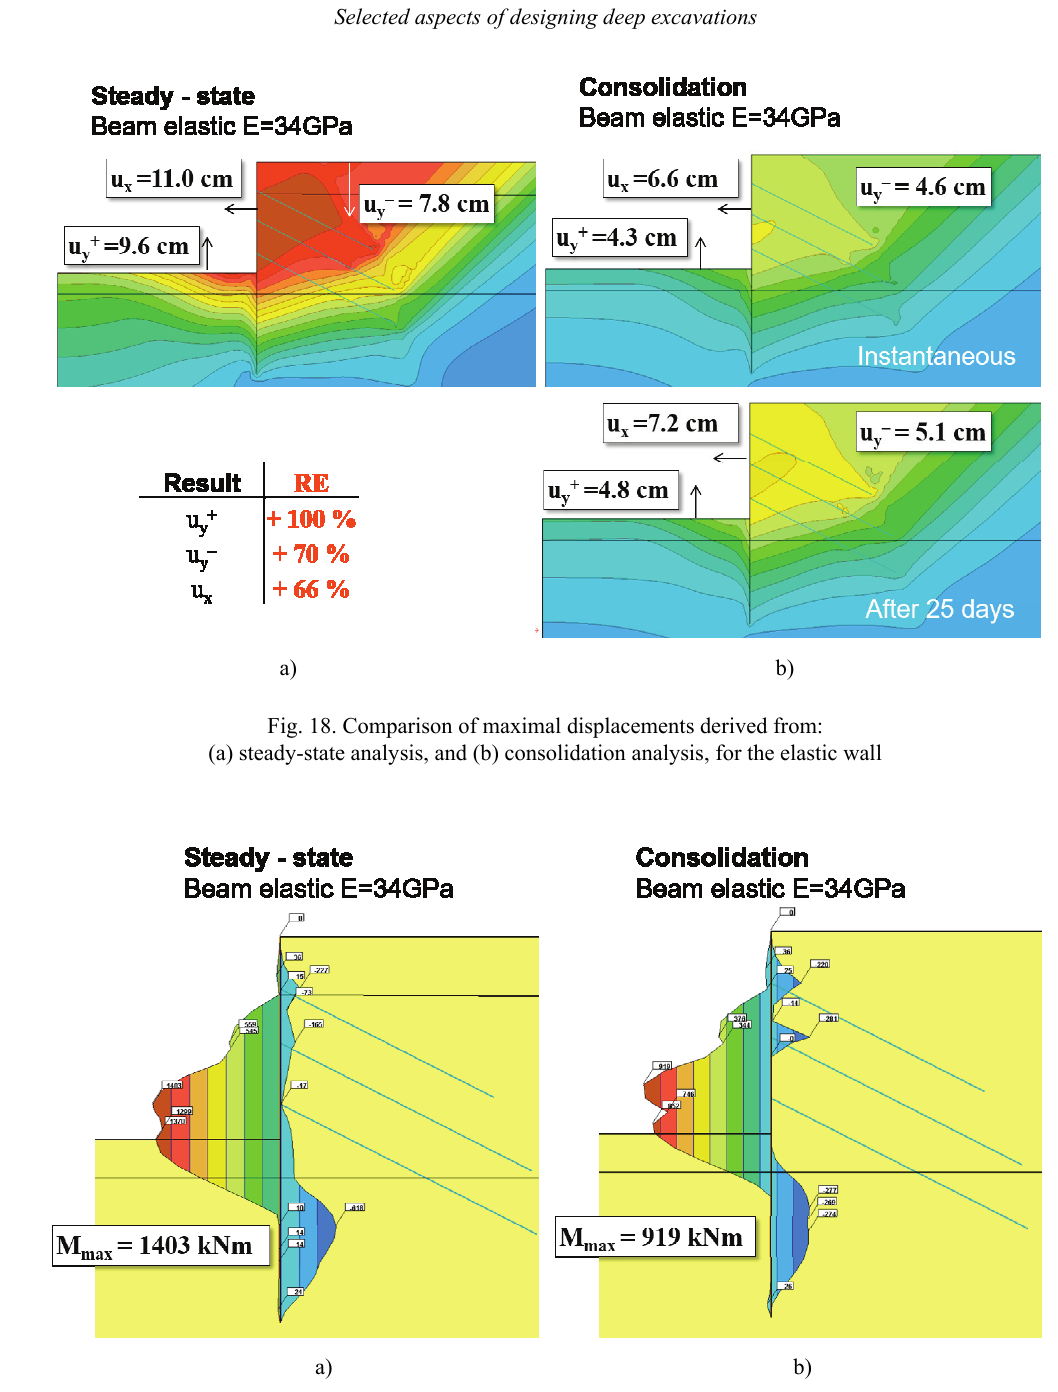
Fig. 19. Comparison of a characteristic bending moment envelopes